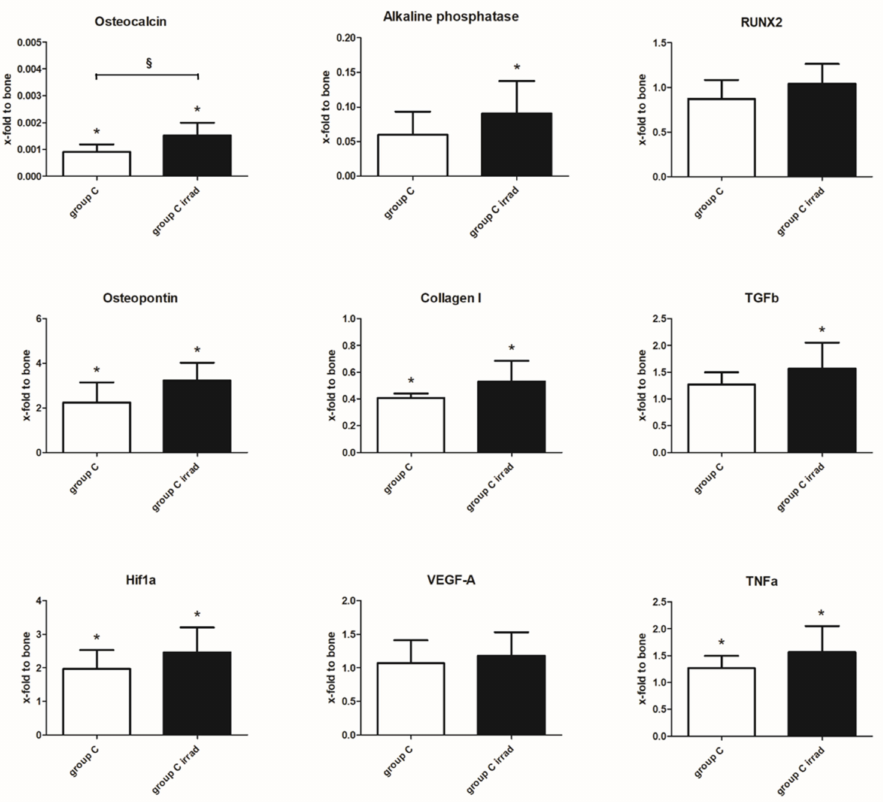
Figure 10. Gene expression of osteogenic, fibrotic, hypoxic, angiogenic and inflammatory markers in irradiated and unirradiated constructs, compared to healthy bone tissue (bone tissue set 1). A significant up or downregulation in comparison to bone tissue is marked with * ( p ≤ 0.05). A significant difference in osteocalcin expression between group C and C irrad was noted (§, p ≤ 0.05). Values are given as mean ±